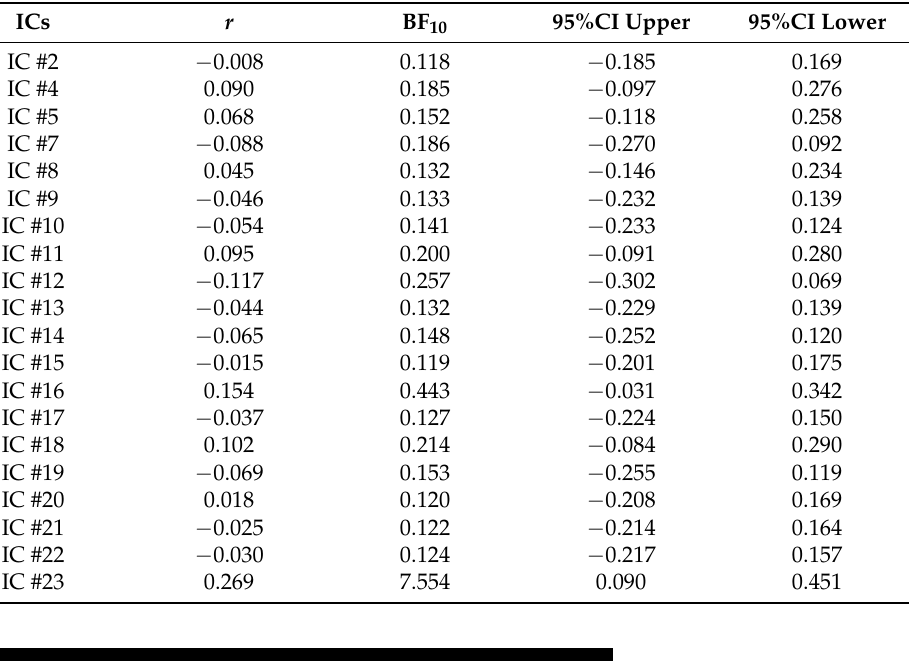
Table 1. The correlation between independent components (ICs) and the RSA (Resilience Scale for Adults) subscale of personal strength (RSA_p).